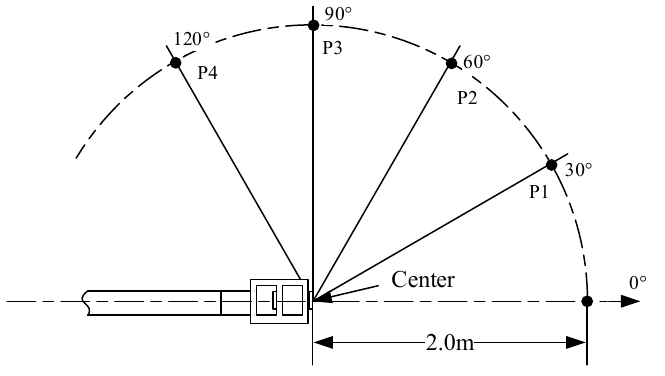
Figure 14. Measurement point locations in the far field.